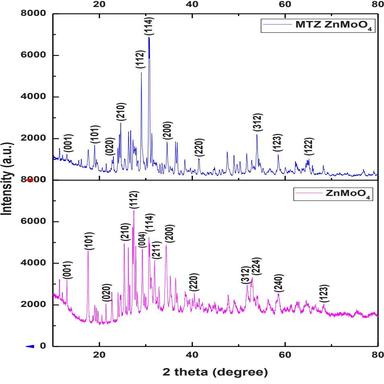
X-ray diffraction spectrum of MTZ - ZnMoO4 and ZnMoO4 nanocomposite material.